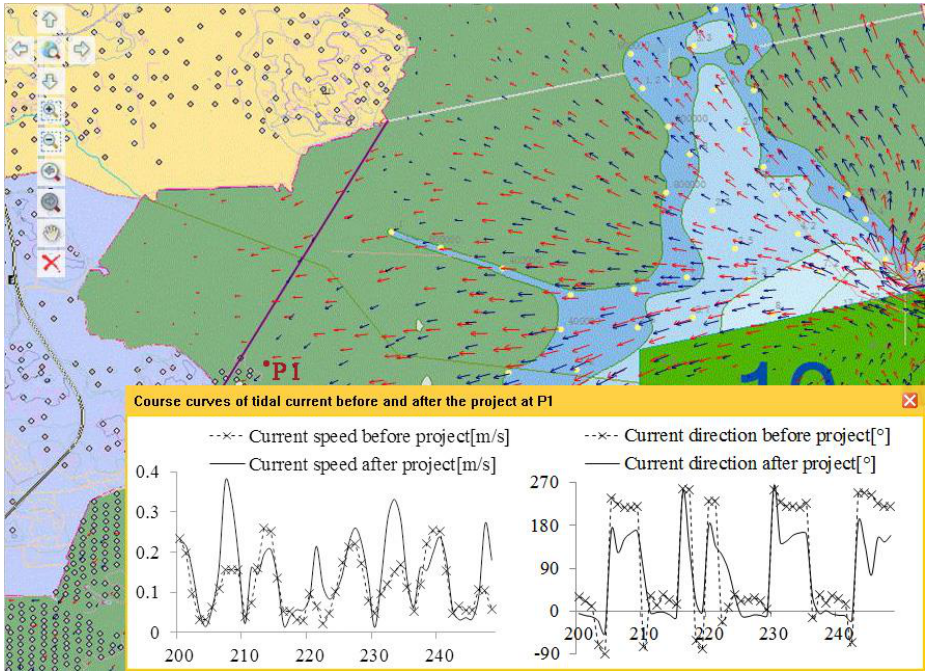
Figure 9. Tidal current course curves before and after the project at a specified point on the webpage. The tidal fields before and after the project are displayed. The flow vector before project implementation is in red, and the one after project implementation is in blue.